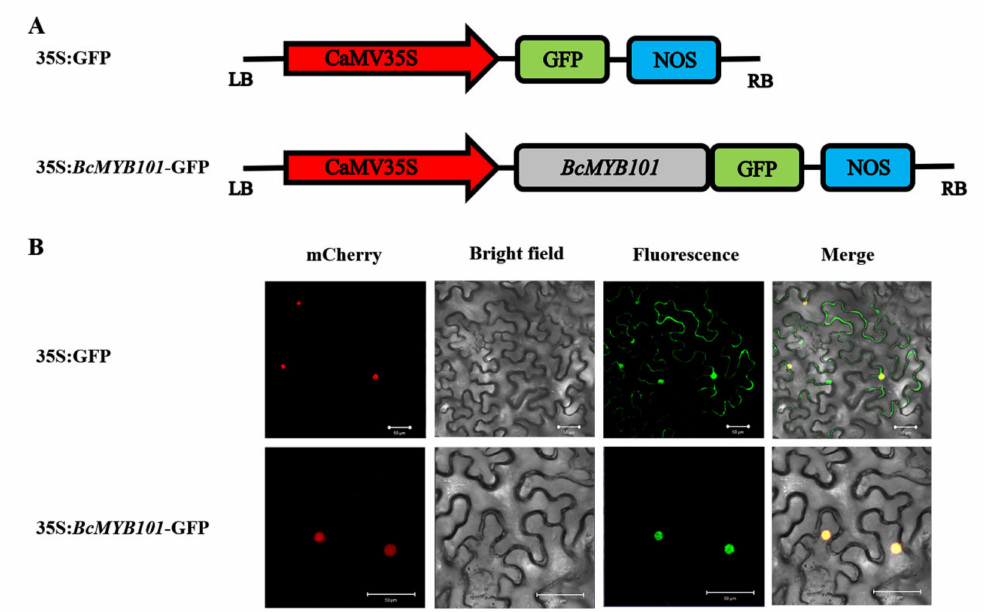
Figure 4. Subcellular localization of BcMYB101 . ( A ) The construct of 35S:GFP (green fluorescent protein) and 35S: BcMYB101 -GFP fusion protein. ( B ) The panels from left to right correspond to the mCherry (nuclear marker), bright-field, fluorescence, and merged fluorescence images of 35S:GFP and 35S: BcMYB101 -GFP fusion protein. Scale bars = 50 µ